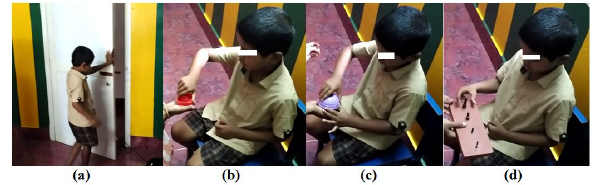
Figure 2: Snapshots of pre-assessment activities (a) Opening and closing of door; (b) Rotating a cubical toy; (c) Twisting a hemispheri- cal toy; (d) Screwing action using bolt-nut